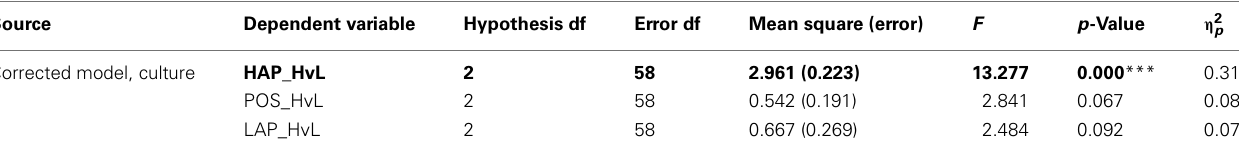
TableA8 | Univariate tests of simple effects of intensity difference scores from ipsatized data.